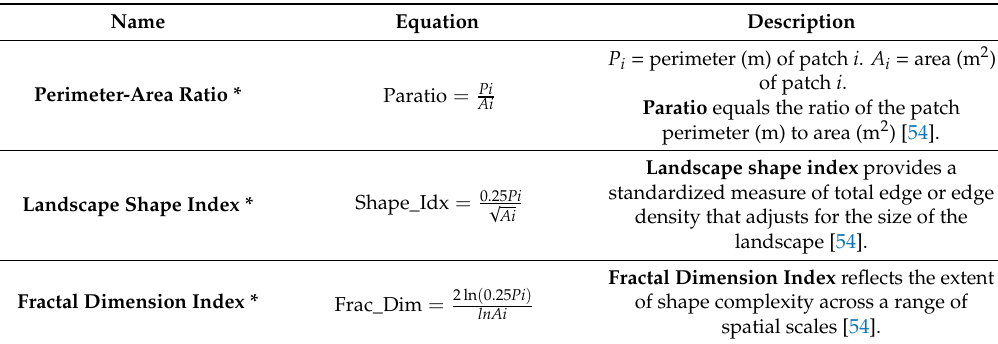
Table 3. Park metrics used in this study.